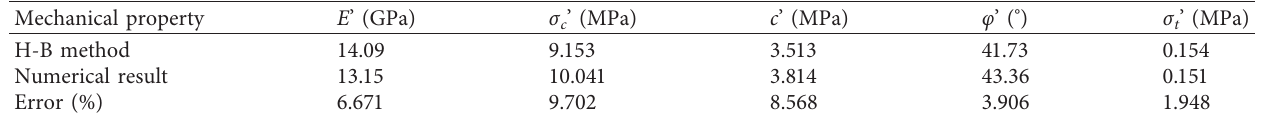
Table 11: Comparison of mechanical parameters between the H-B method and numerical tests.